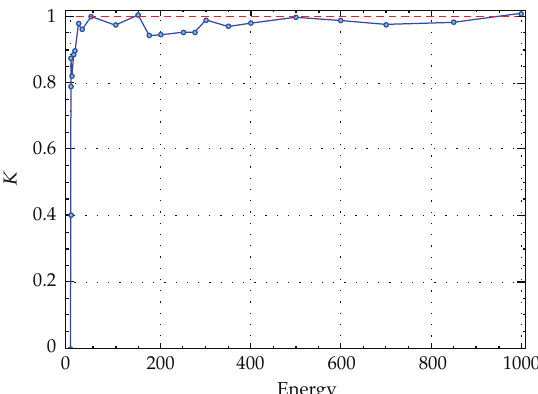
Figure 12: K versus Energy in sixth-order Hamiltonian. The red dashed line corresponds to K (cid:7) 1.